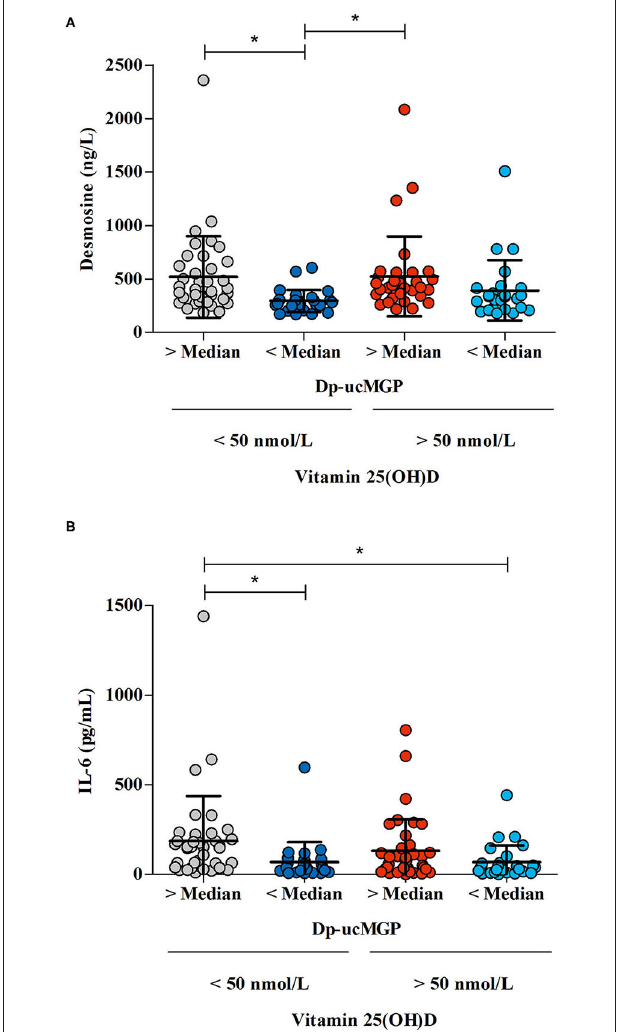
FIGURE 4 | The association between the differences in vitamin K status /vitamin D status /desmosine and IL-6 levels in COVID-19 patients. Vitamin K levels were defined as “low” when dp-ucMGP levels were above median, and “high” when dp-ucMGP levels were below median. Vitamin D levels were defined as “low” when there was a 25(OH)D insufficiency (concentration < 50 nmol/L) and “high” when there was a sufficient amount of vitamin D (concentration > 50 nmol/L). (A) The effect of vitamin K status — derived from dp-ucMGP status — on desmosine levels in patients with high or low vitamin D levels. Desmosine levels were measured in 122 patients. (B) The effect of vitamin K status — derived from dp-ucMGP status — on IL-6 levels in patients with high or low vitamin D levels ( n = 131). * Indicates significant difference between